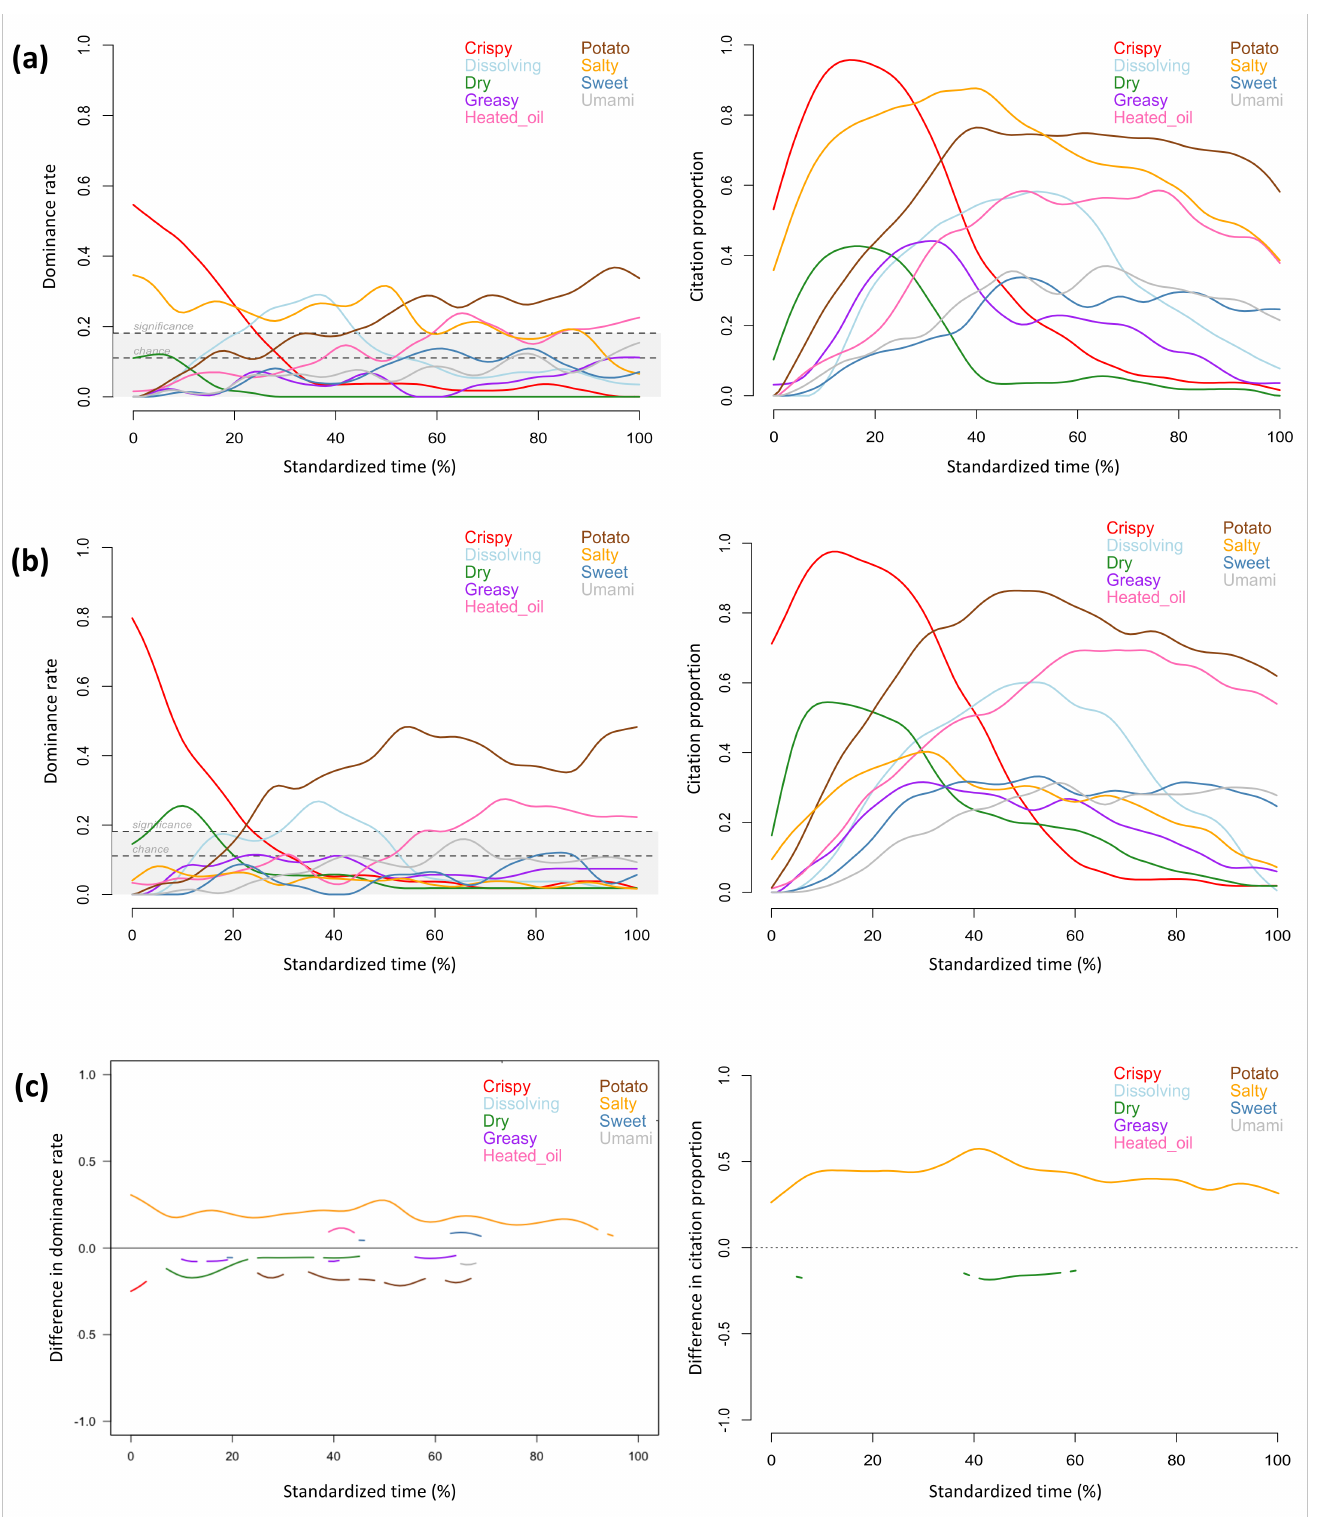
Figure 1. Temporal profiles for regular ( a ) and sodium-reduced ( b ) chips, and significant difference curves ( c ) obtained by TDS (left) and TCATA (right) evaluations of the first intake (n =